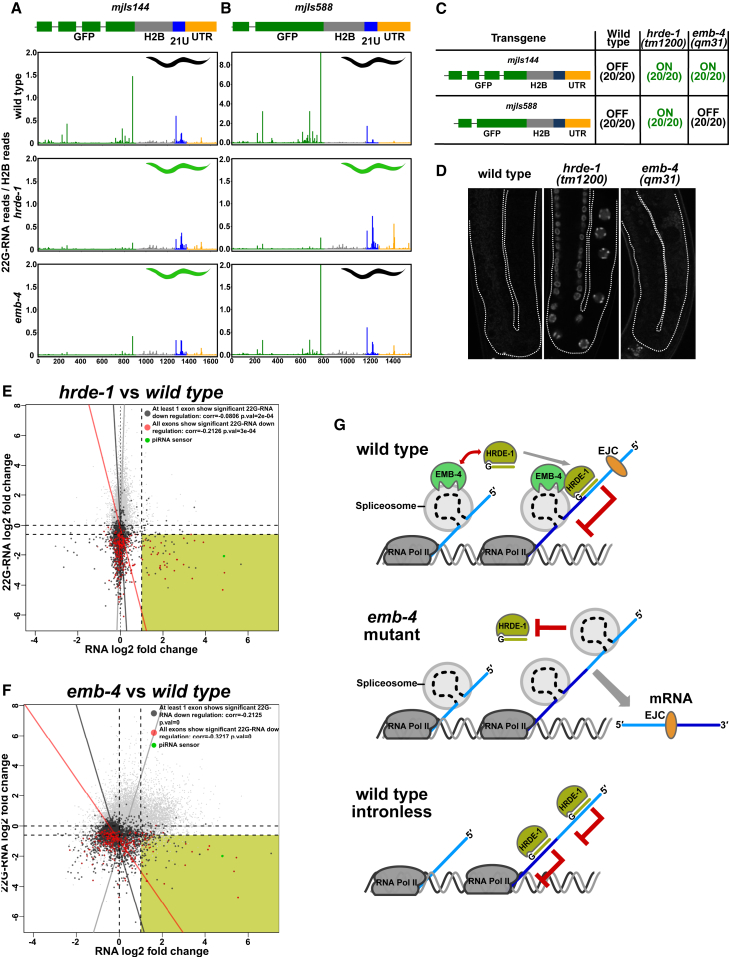
Aquarius/EMB-4 Acts to Remove Intronic Barriers to Transcriptional Gene Silencing(A and B) 22G-RNA profiles of the three-intron (A) and the single-intron (B) piRNA sensors in wild-type, hrde-1, and emb-4 mutant animals (mean 22G-RNA abundance of three replicates) (y axis scale in wild-type animals of B is different from that of A; colors indicate different regions of the sensor transgene).(C) Silencing of the three-intron piRNA sensor (mjIs144) and the single-intron piRNA sensor (mjIs588) in wild-type and mutant animals (20 animals assayed for each condition).(D) Fluorescent microscope images of animals with the single-intron piRNA sensor (mjIs588). Germline boundaries are marked by the white dotted lines.(E and F) mRNA expression levels correlate negatively with 22G-RNA abundance and correlation increases when more exons are targeted by 22G-RNAs (gray line, all genes; black line, genes that show significant 22G-RNA change in one exon; red line, genes that show significant 22G-RNA change in all exons). The x axis shows log2 fold change of 22G-RNAs in mutants/wild-type and the y axis shows log2 fold change of mRNA in mutants/wild-type (correlation coefficient and p values are shown on graphs).(G) Model for Aquarius/EMB-4 function in intron-dependent transcriptional gene silencing.